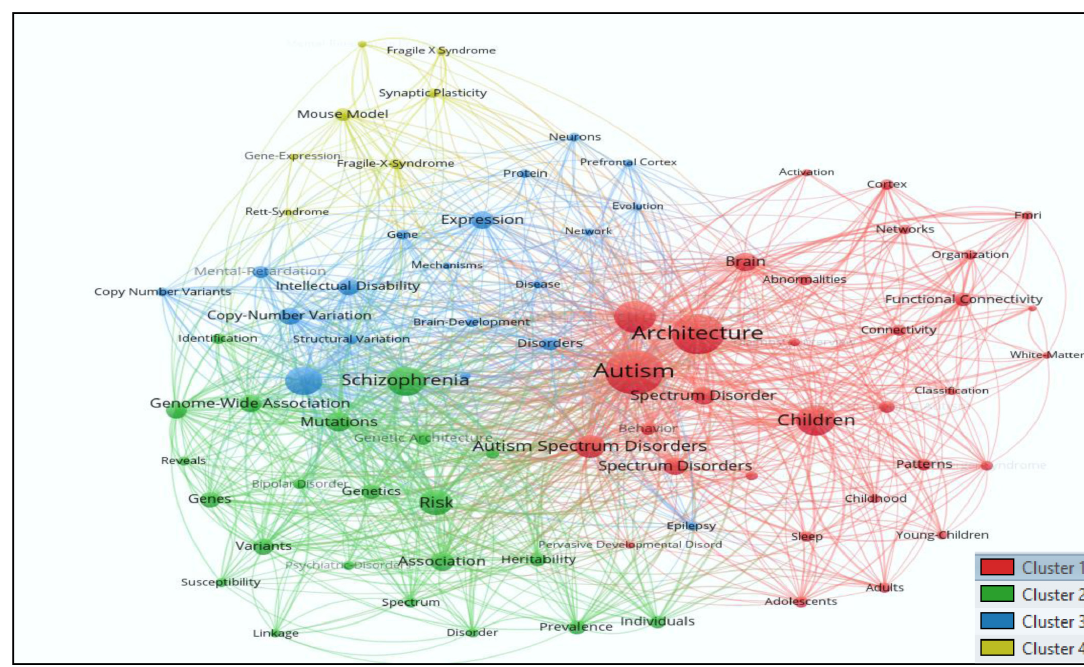
Figure 3. Keyword analysis using